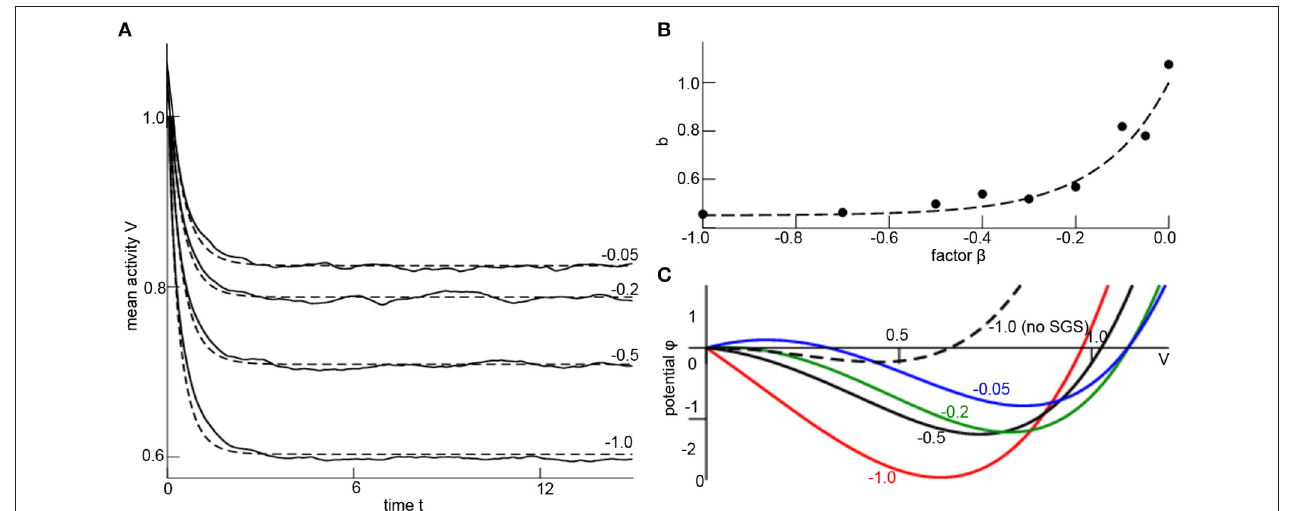
FIGURE 2 | Subgrid-scale modeling. (A) Network mean (solid line) computed from simulations of Equation (1) and mean-field dynamics (7) for different values of β (numbers given) and corresponding optimally estimated factors b . Parameters are V i (0) = x 1 (0) = 1.1, δ t = 0.03, K 0 = 1.0, D = 0.33, γ 1 = 2.0, γ 2 = 0.0, γ 3 = − 1.0, α = 0.0, N = 1000, c = 0.9 and initial condition V i (0) = 1.1 ∀ i = 1, ... , N . The results have been gained for a single network realization, while the variance of results for multiple network realizations is found to be negligible for N ≥ 1000 (data not shown). The optimal factor b has been estimated by employing the Python library pyswarms utilizing the routine single.GlobalBestPSO with optional parameters c 1 = 0.5, c 2 = 0.5, w = 0.3, 60 particles, 50 iterations and taking the best fit over 20 trials. (B) The estimated factor b for different values of β (dots) and the fit polynomial function (dashed line; see Equation 8). (C) The resulting potential φ ( V ) with d φ/ dV = − F [ V , b ( β )], F is taken from Equation (7), where b is computed from β (numbers given) by Equation (8). The dashed line is plotted for comparison illustrating the impact of the SGS.